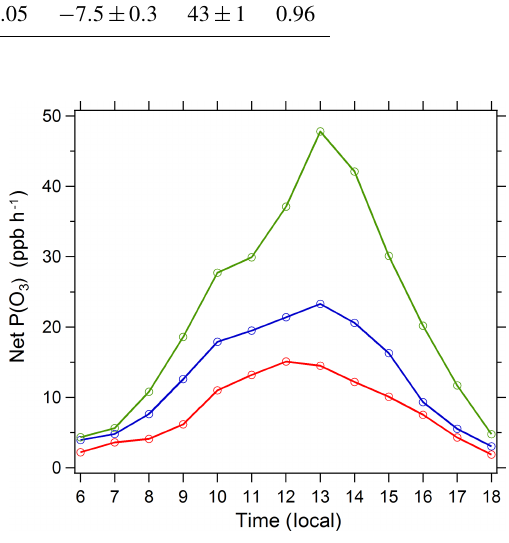
Figure 11. Diurnal profile of net P (O 3 ) simulated by the box model. Three cases are displayed: (1) A day (red circles), 21 Au- gust 2012, with a low AOD level and high photolysis frequencies; (2) B day (blue circles), 26 August 2012, with a high AOD level and low photolysis frequencies; and (3) the photolysis frequencies of B day adjusted to the level of A day with other conditions un- changed (green circles). The specific conditions of A day and B day are listed in Table